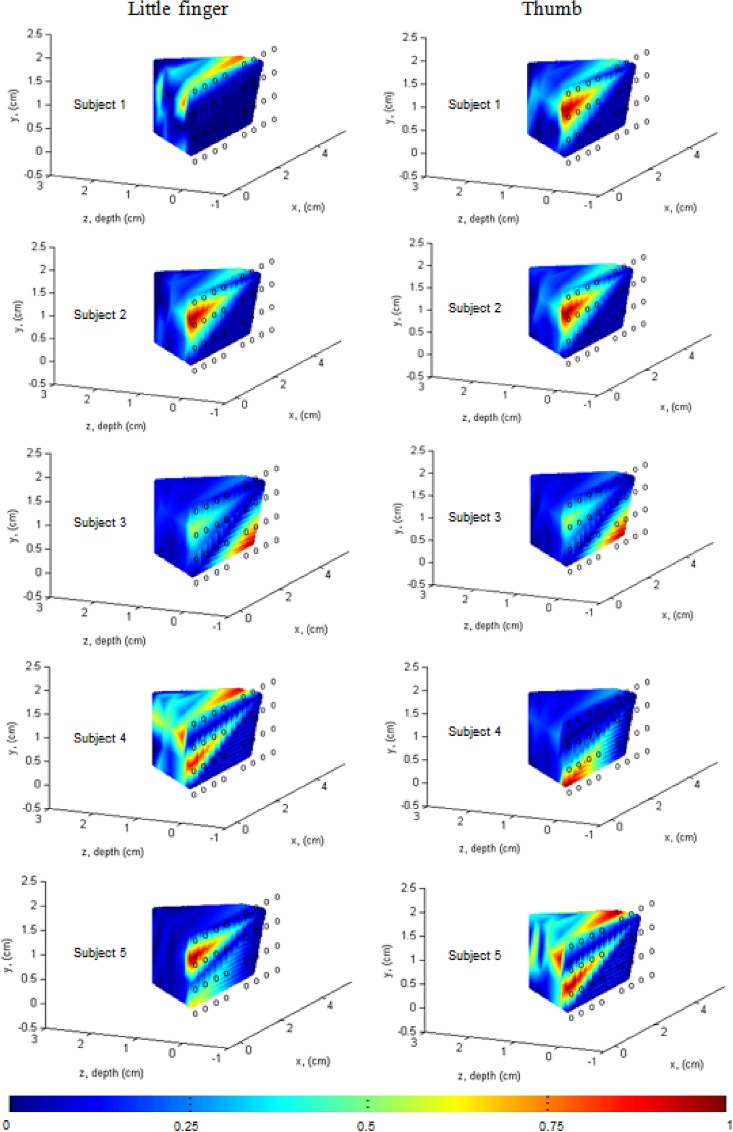
Local activation maps of little (left) and thumb (right) finger movements.The small circles indicate the optodes’ positions and the color bar at the bottom denotes the activation strength according to the normalized mean value between 0~1 range.